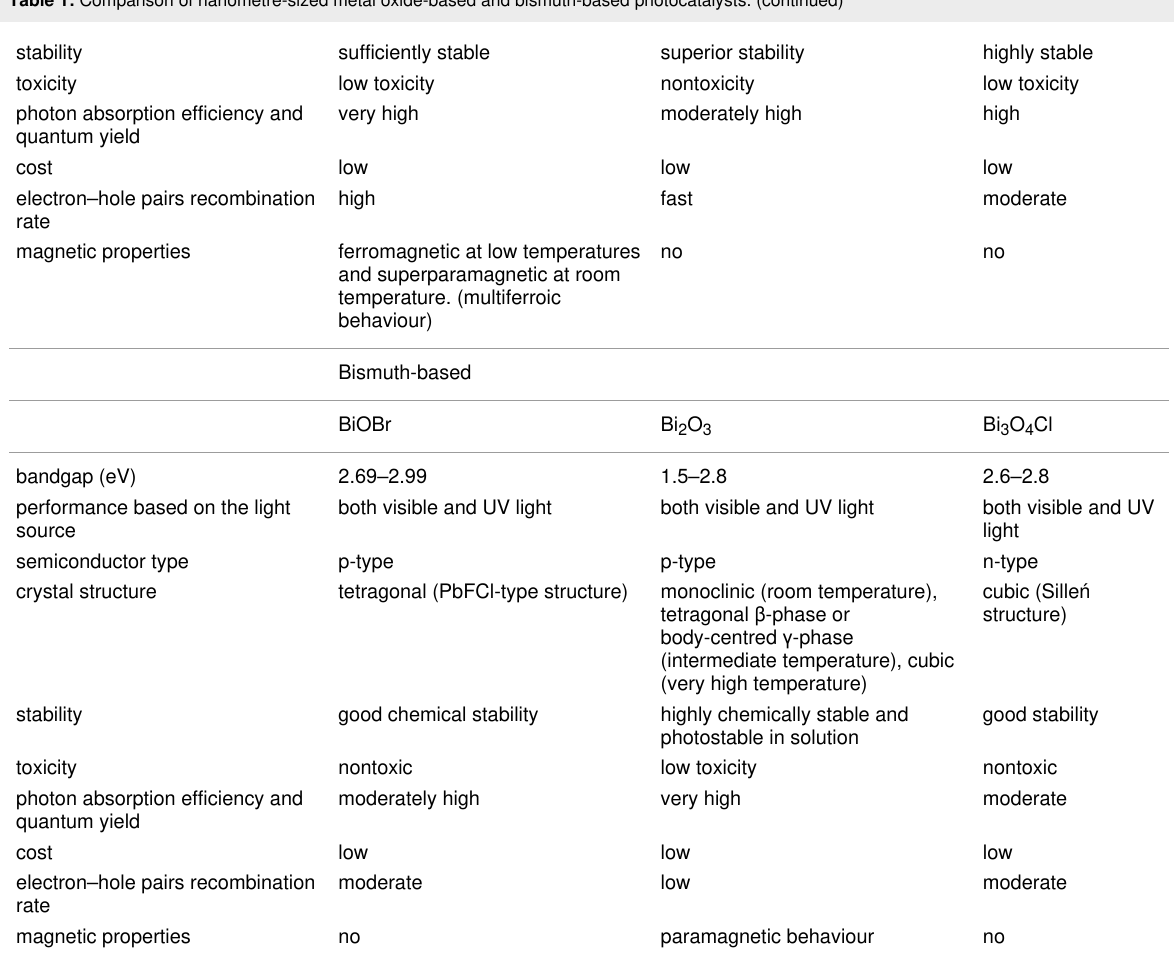
Table 1: Comparison of nanometre-sized metal oxide-based and bismuth-based photocatalysts.